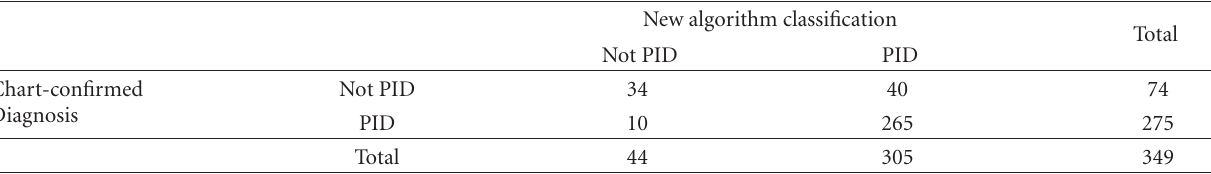
Table 3: Performance statistics for PID case identification using an algorithm applied to sample administrative data from women with an ICD-9 code ∗ related to